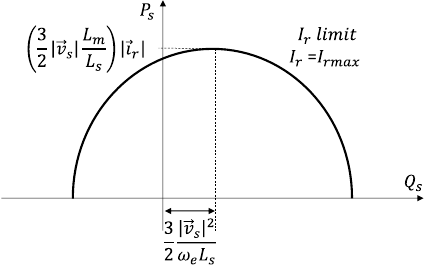
Figure 9. Stator 𝑃 𝑠 − 𝑄 𝑠 boundaries for rated current of the rotor. Figure 9. Stator P s − Q s boundaries for rated current of the rotor. Figure 9. Stator 𝑃 (cid:3046) − 𝑄 (cid:3046) boundaries for rated current of the rotor.